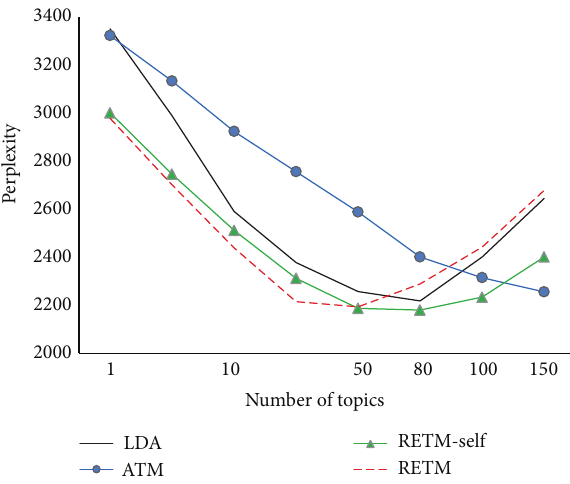
Figure 4: Perplexity values for different numbers of topics ( BOOK ). Figure 5: Perplexity values for different numbers of topics ( PAPER ).